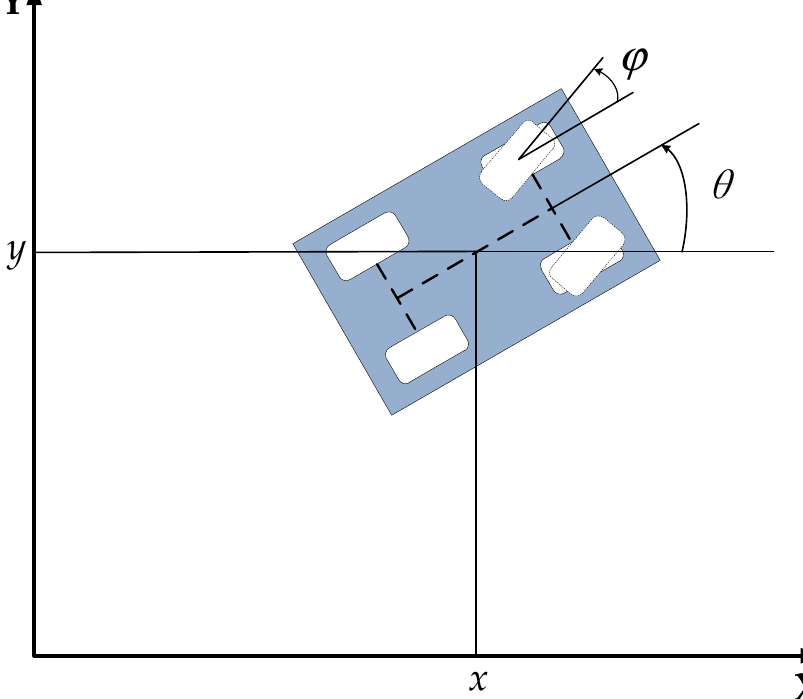
Figure 6. Mathematical model of wheeled mobile robot.